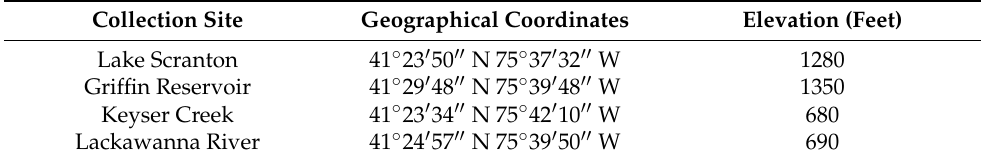
Table 1. Geographical coordinates and elevations for each collection site.